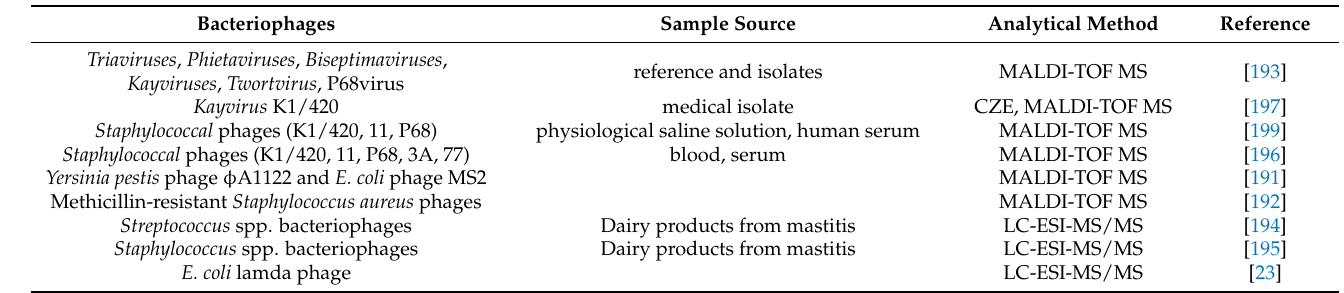
Table 2. Bacteriophage identification as a means to recognize pathogenic bacteria. This is a summary of relevant bacteriophages that have been analyzed by MS-related techniques, resulting in the identification of the pathogenic bacteria that harbored